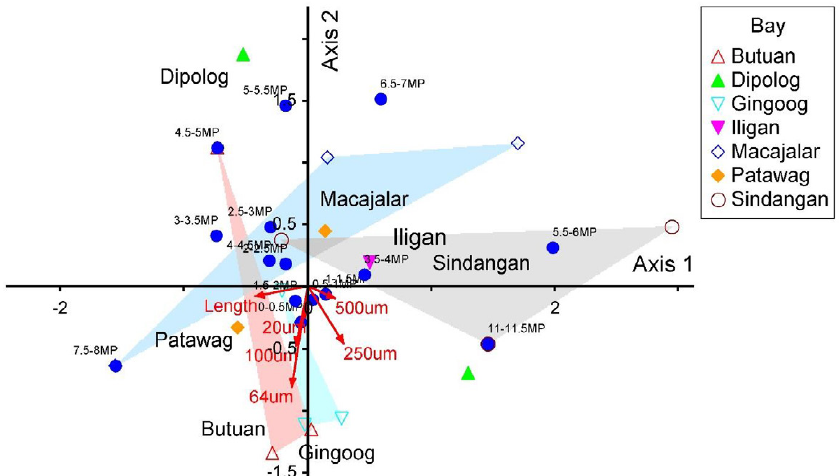
Fig. 5: CCA biplot of bays and densities of microplastic at different size classes with standard length, and size classified food particles of S. lemuru as explanatory variables